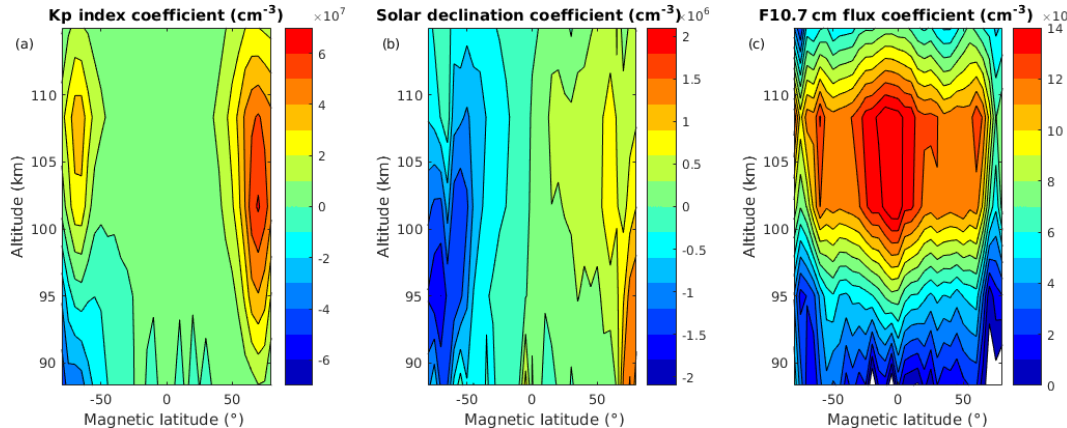
Figure 8. The coefficients of the (a) Kp index, (b) Solar declination, and (c) F10.7cm flux, in Eq.